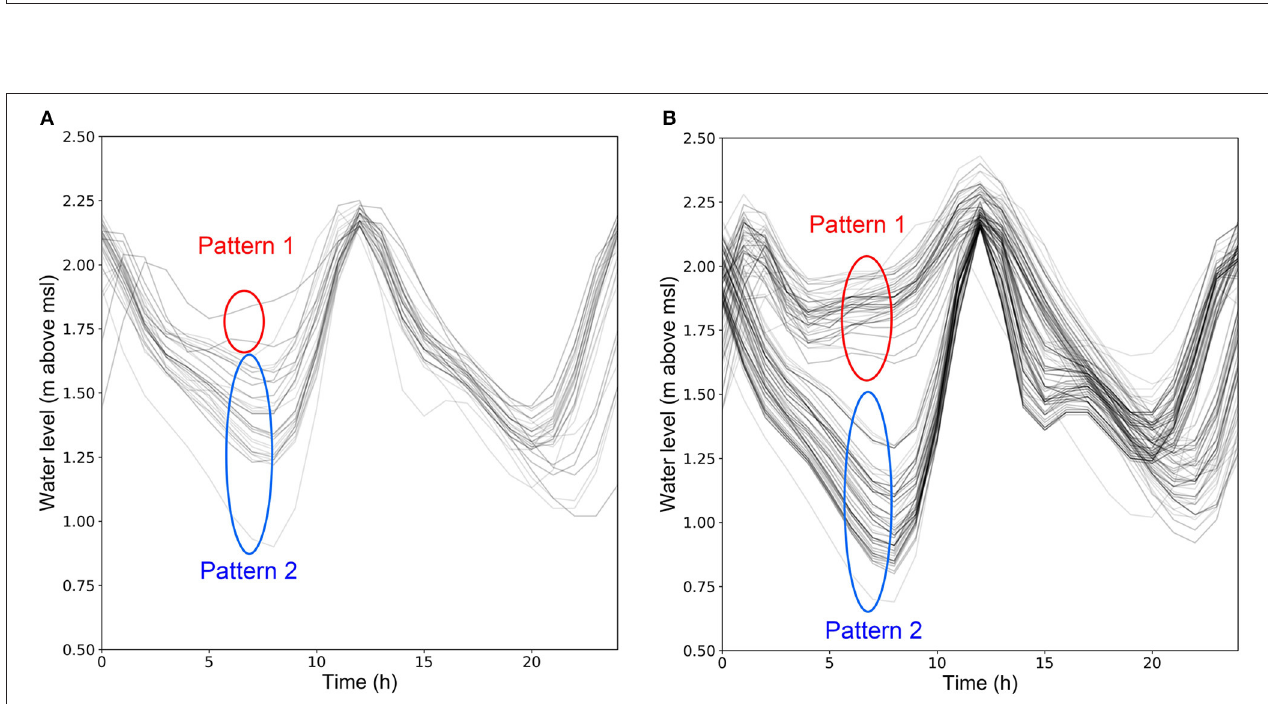
FIGURE 9 | Analysis of 24-h time series around modeled peak water levels indicating two flood hydrograph patterns in the future scenario, (A) 2050 (RCP4.5), (B) 2050 (RCP 8.5).